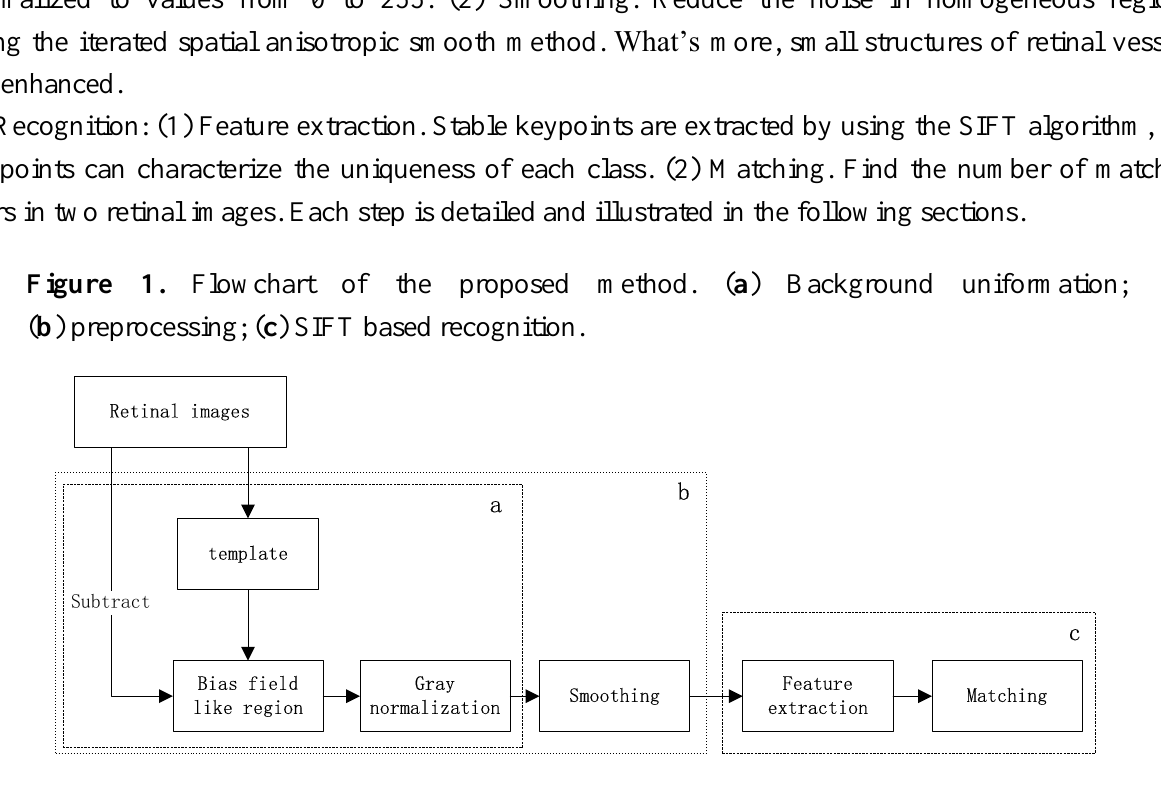
b a Feature Gray Smoothing extraction